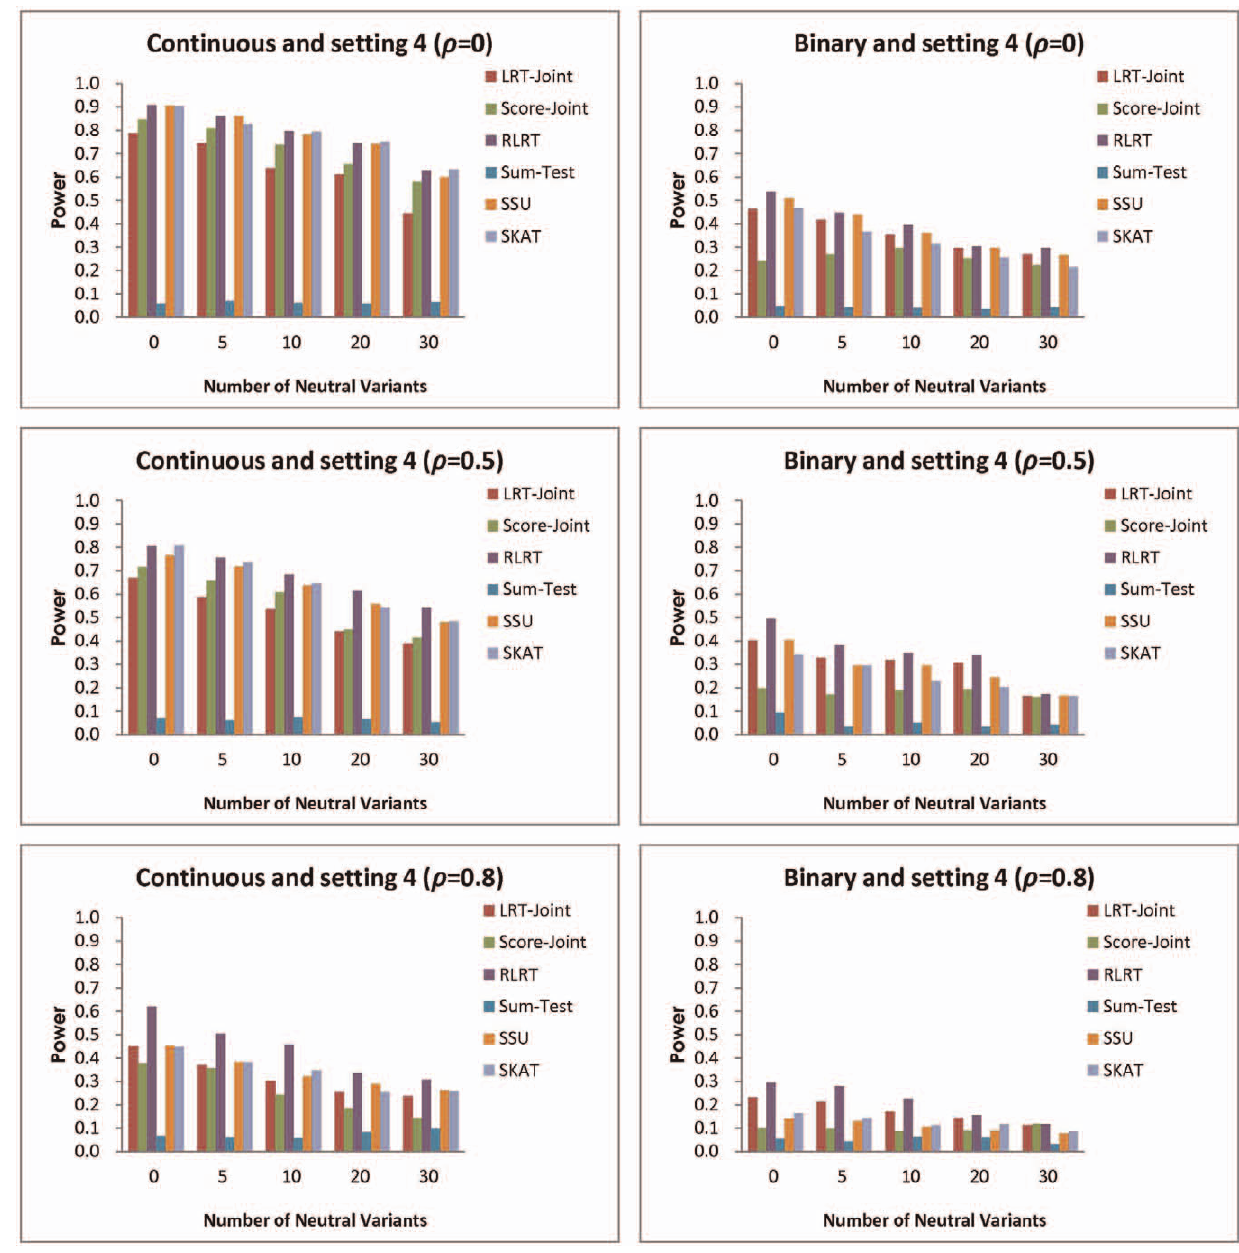
Figure 6. Simulation setting 4: b k ~ ( 0 : 6 , { 0 : 6 , 0 : 5 , { 0 : 5 , 0 : 4 , { 0 : 4 , 0 : 3 , { 0 : 3 , 0 : 2 , { 0 : 2 ) T ( continuous trait ) ; OR ~ ( 2 : 4 , 1 = 2 : 4 , 2 : 1 , 1 = 2 : 1 , 1 : 8 , 1 = 1 : 8 , 1 : 5 , 1 = 1 : 5 , 1 : 2 , 1 = 1 : 2 ) T ( binary trait )